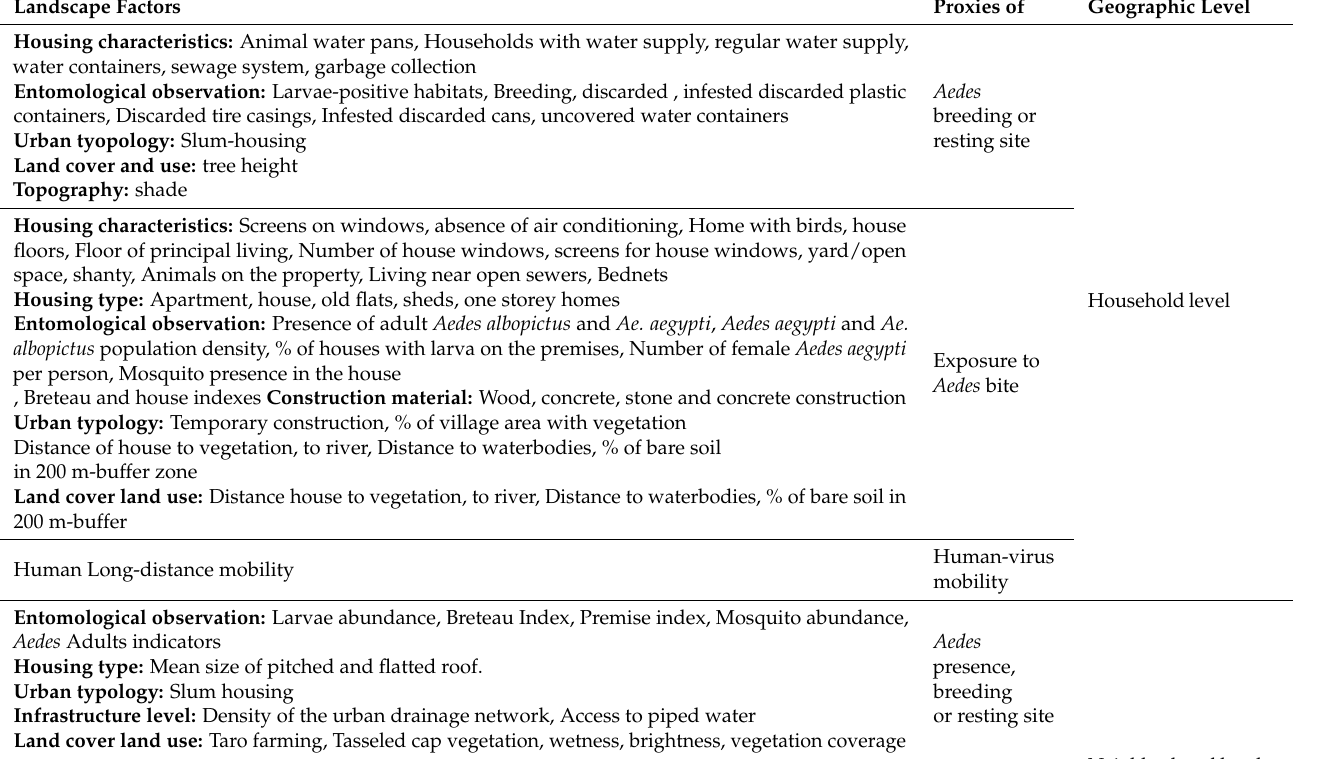
Table 4. Landscape factors interpreted as proxies of different processes involved in dengue transmission according to the geographical level of data